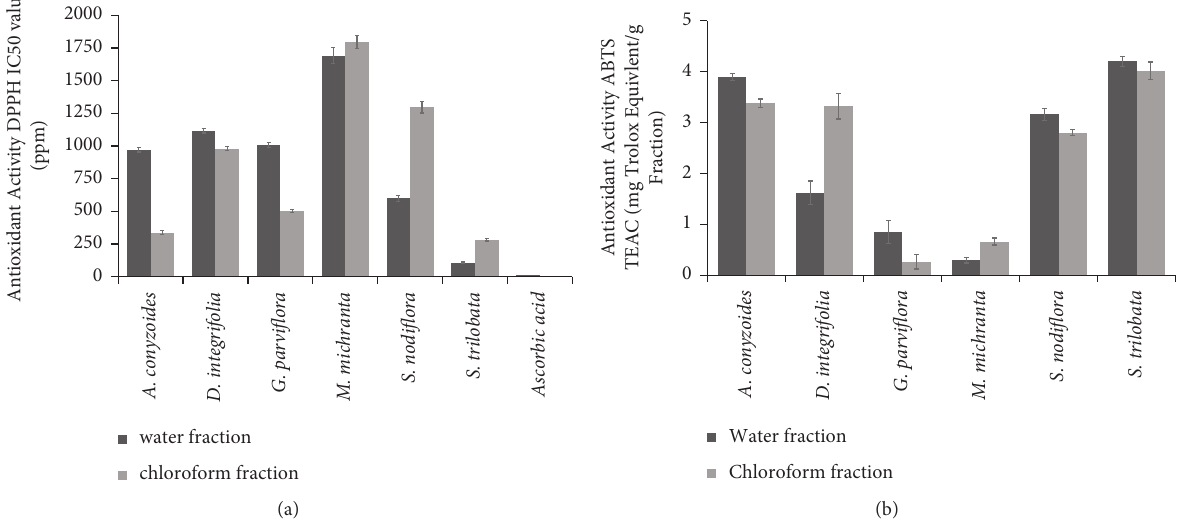
Figure 1: Antioxidant activity of fractions tested in this study. (a) DPPH activity expressed in IC DPPH radicals at 50%). (b) ABTS method depicted in TEAC (Trolox equivalent antioxidant activity) mg Trolox equivalent/g